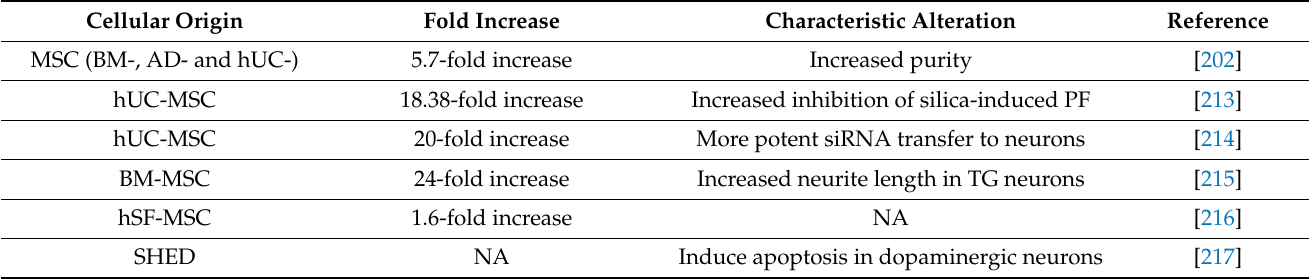
Table 5. Microcarrier culture methods used to increase the yield or enhance the properties of